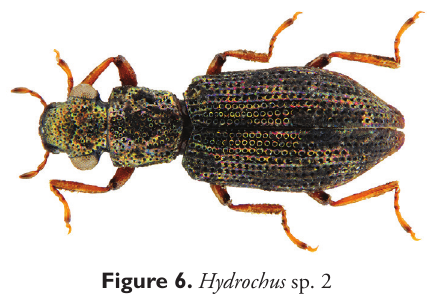
Figure 6. Hydrochus sp. 2